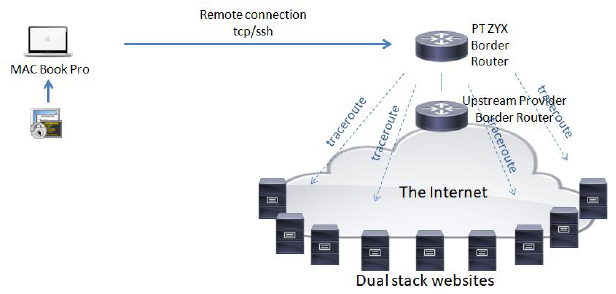
Fig. 8. Hop count test